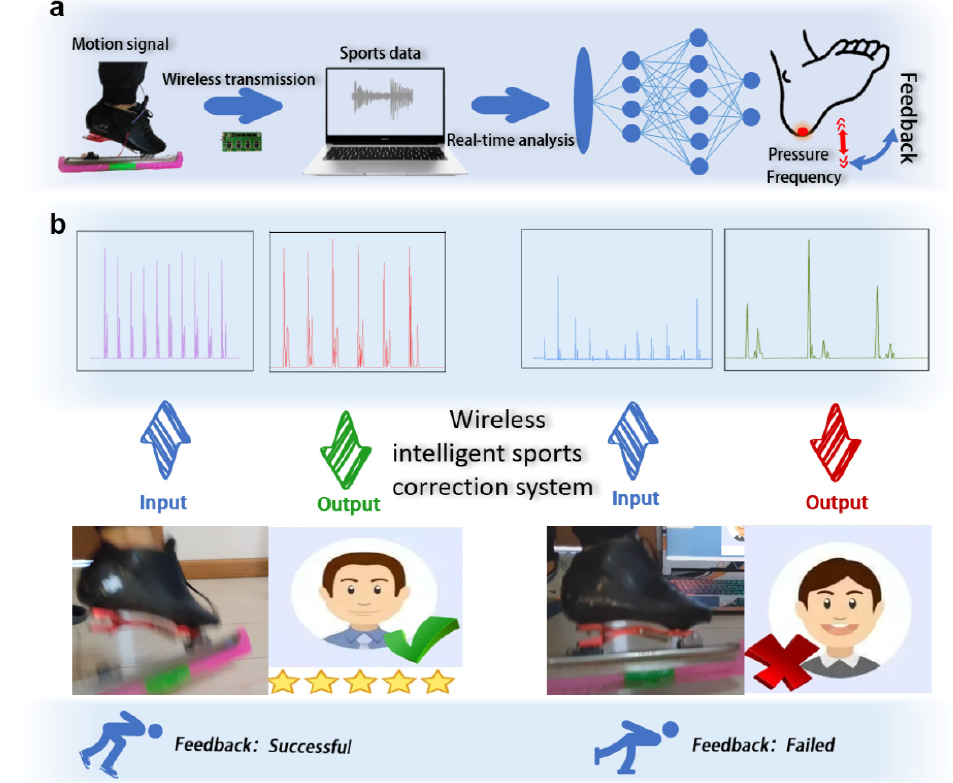
Figure 5. Application of the LPS-TENG in a wireless intelligent motion correction system. ( a ) Work- flow of the wireless intelligent motion correction system. ( b ) The specific process of the wireless intelligent motion correction